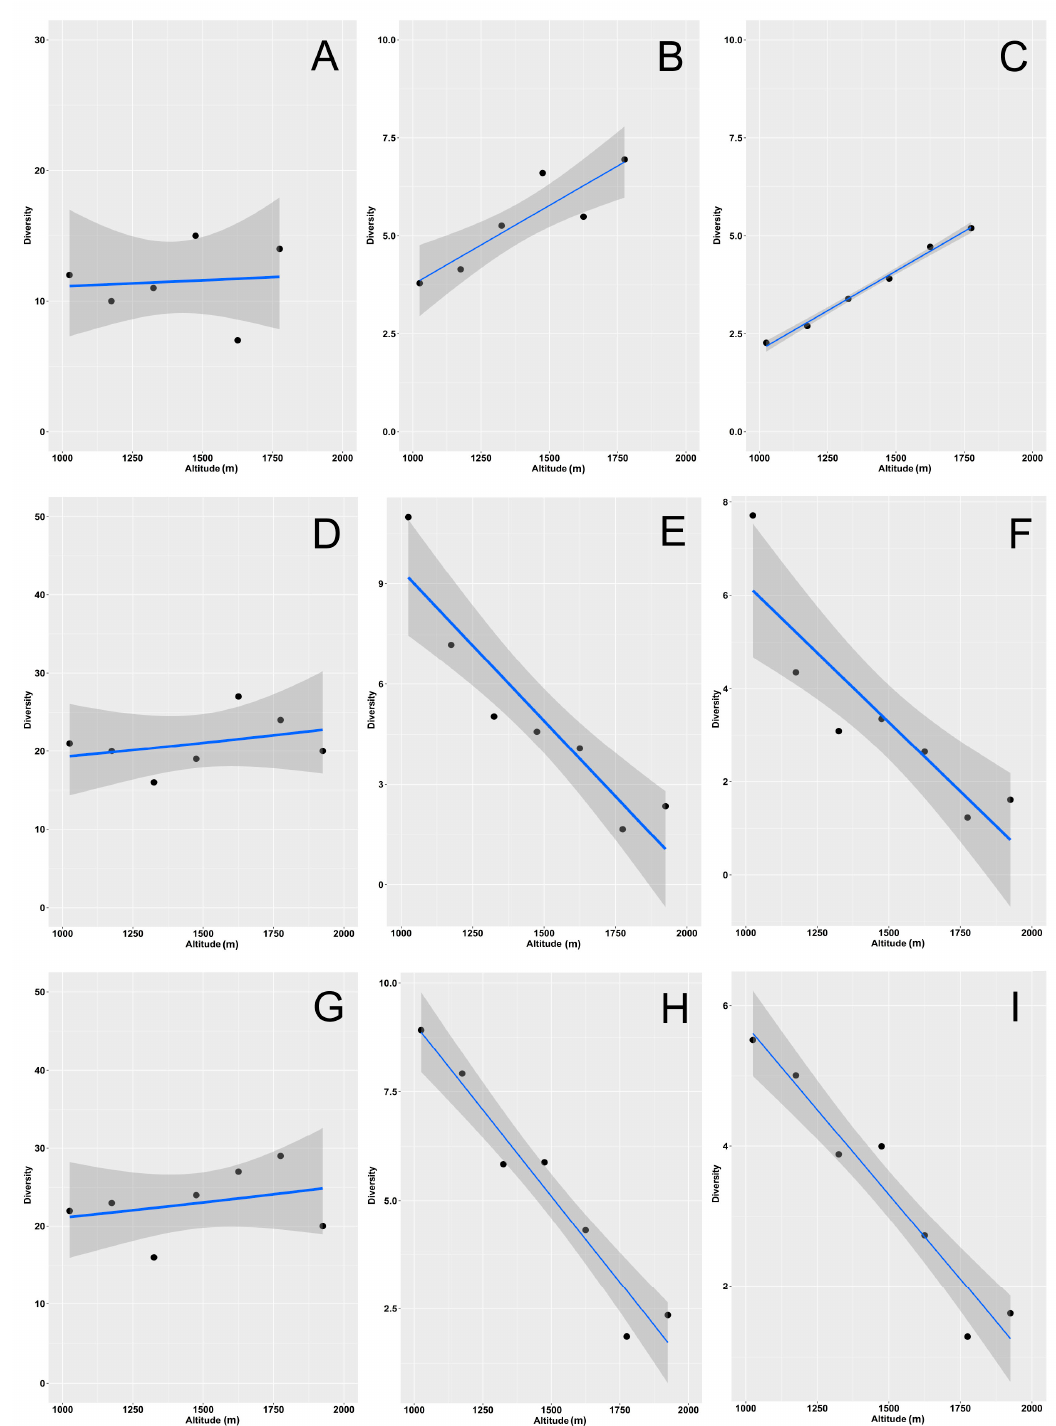
Figure 2. Relationship of dung beetle species richness ( A , D , G ), exponential Shannon diversity ( B , E , H ), and Simpson diversity ( C , F , I ) with altitude along an elevational gradient in central Italy. Curves were constructed using empirical values for the two habitats (woodlands and grasslands) separately (woodlands: A – C ; grasslands: D – F ) and merged ( G – I ). General linear models were used for fitting. Dashed areas are 95% confidence intervals.